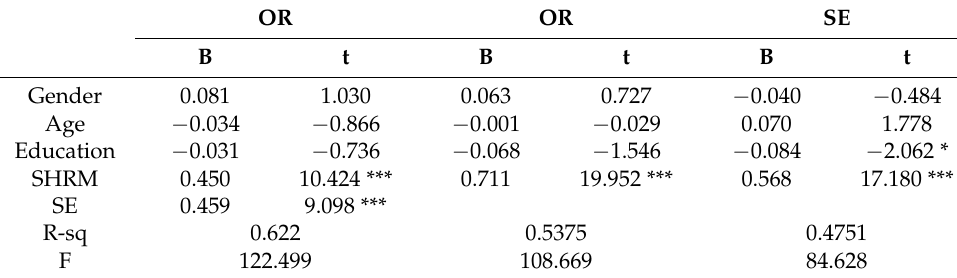
Table 4. Mediated model test of self-efficacy. OR OR SE B